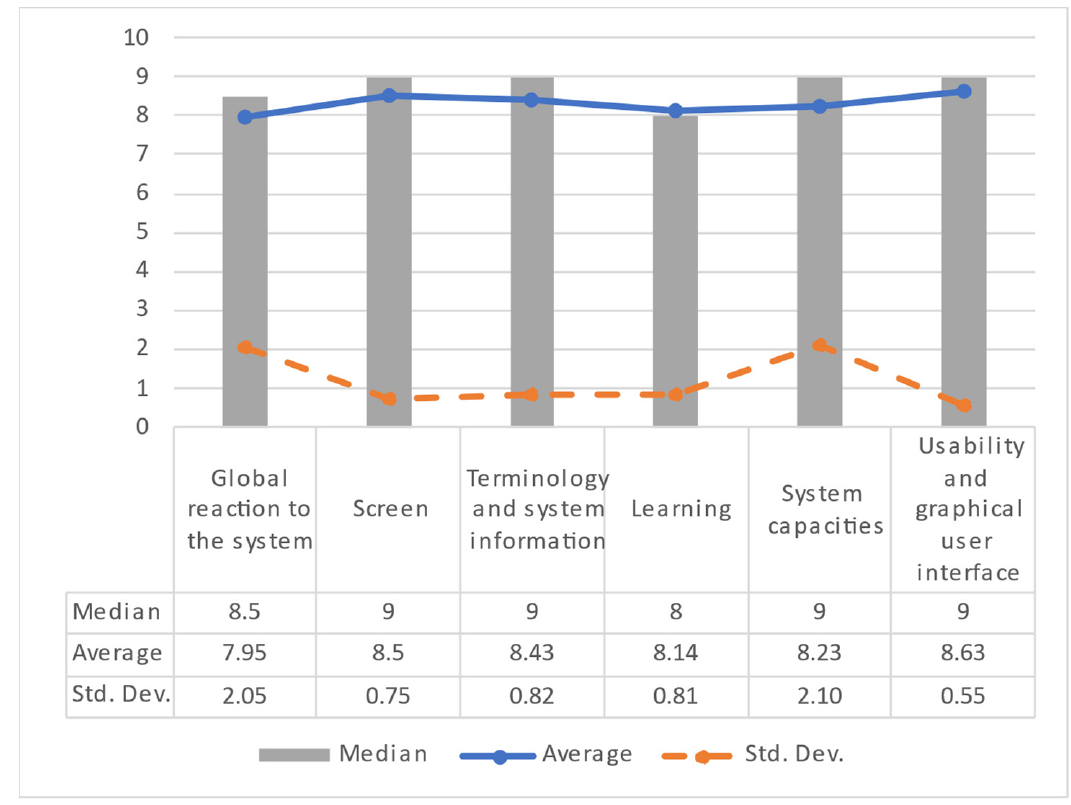
Figure 10. Doctor user satisfaction results by category.